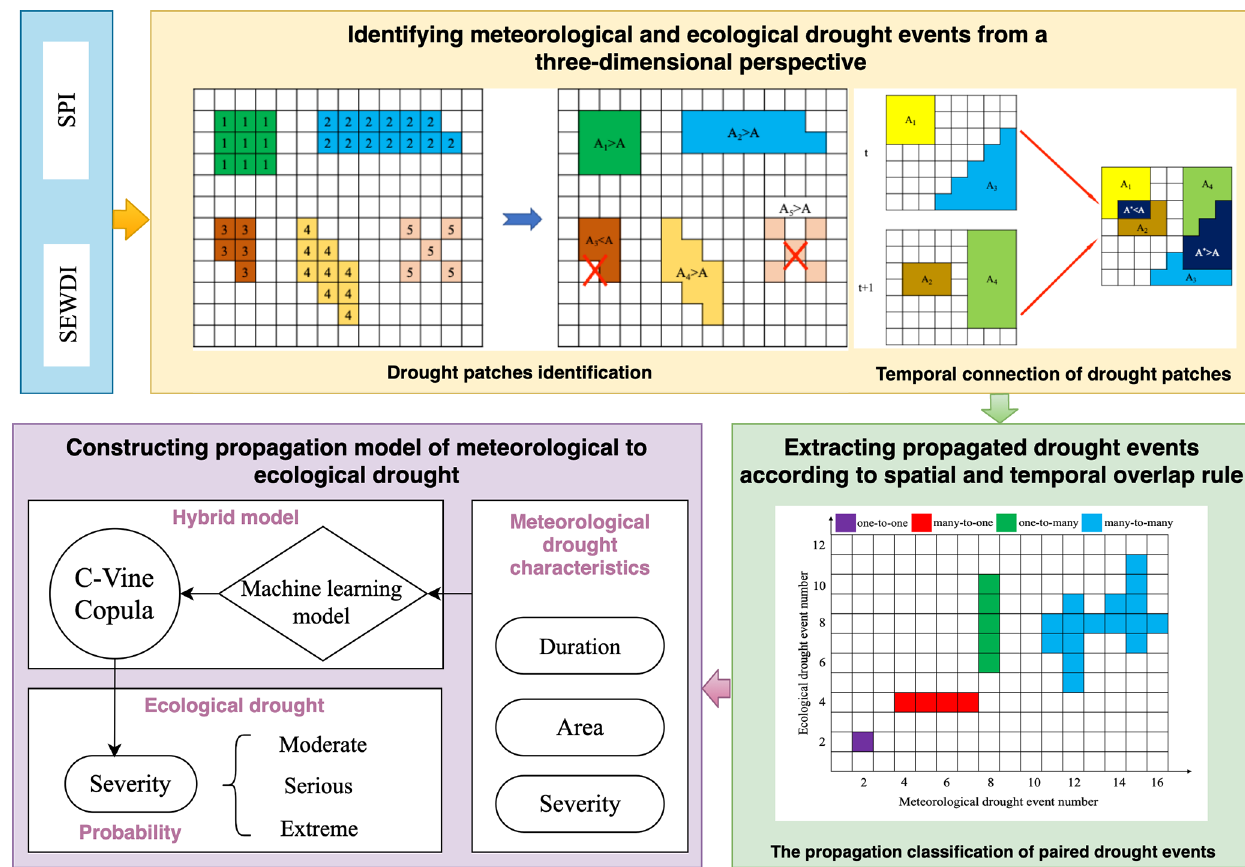
Figure 2. A schematic diagram illustrating the procedure of the drought propagation identification